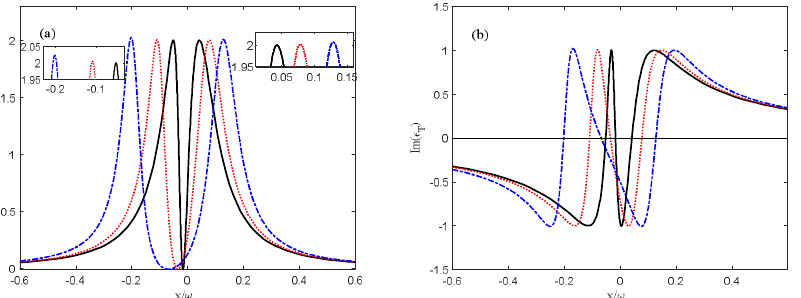
 as a function of normalized de- T